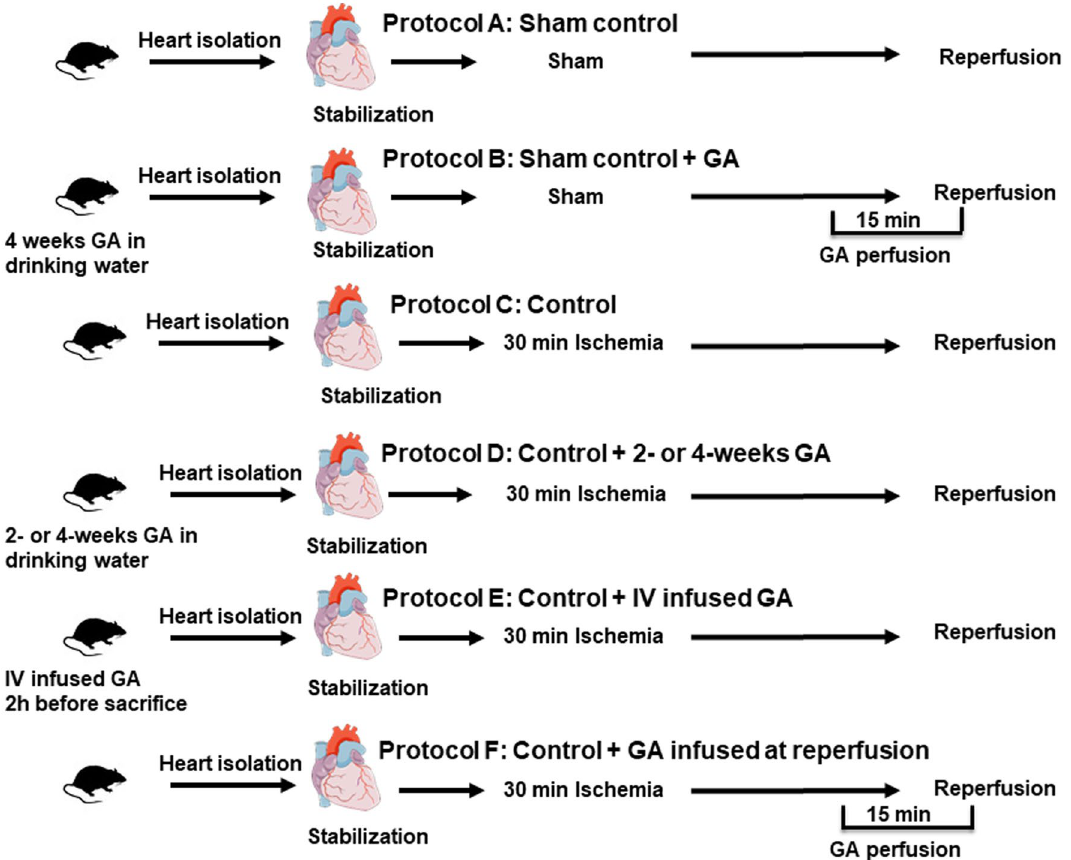
Figure 1. Schematic representation showing the experimental protocols used in the study (n = 8). A: vehicle treated sham controls. B: GA treated sham controls. C: unprotected ischemia–reperfusion control (Ctr). D: protection with 2 or 4 weeks GA in the drinking water, E: IV infused GA, F: GA infused with the perfusion buffer 5 min before reperfusoin and continued for 10 min after the start of reperfusion. GA Gum Arabic, IV intravenous